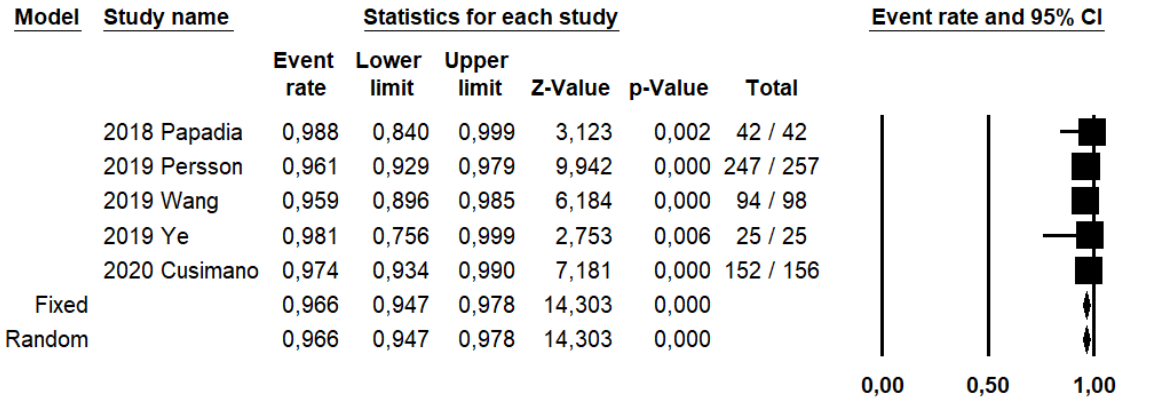
Figure 4. Forest plots of individual studies and pooled detection rate of sentinel lymph node per patient.